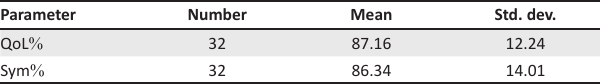
FIGURE 2: Distribution of patients according to clinical findings utilising the clinical, etiology, anatomic and pathology classification (n). TABLE 3: Mean quality of life and Sym scores.